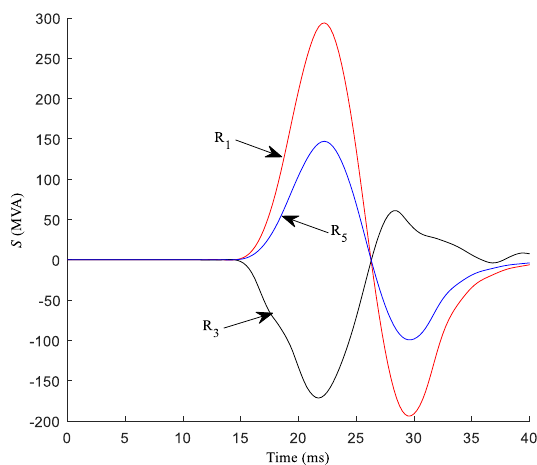
Figure 13. The average products that were detected by R 1 , R 3 , and R 5 for a phase B fault on l 3 (phase B saturation of CT 3 ).